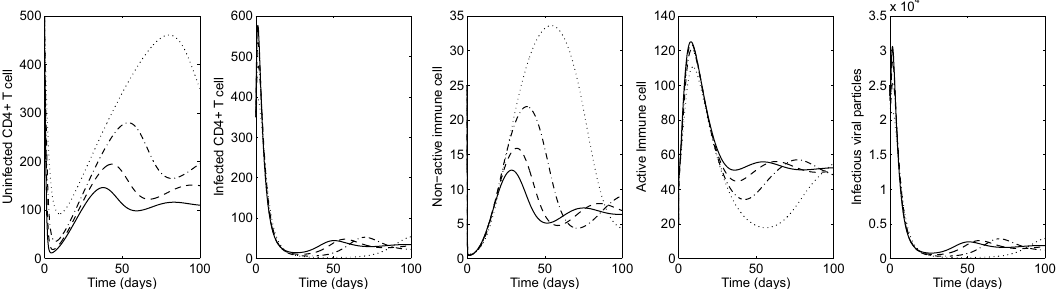
Figure 3. Advanced-stage HIV dynamics in the absence of controls under four different values of β ( γ = 0.004 is fixed): β = 0.000015 (dotted), β = 0.000025 (dash-dot); β = 0.000035 (dashed) and β = 0.000045 (solid).